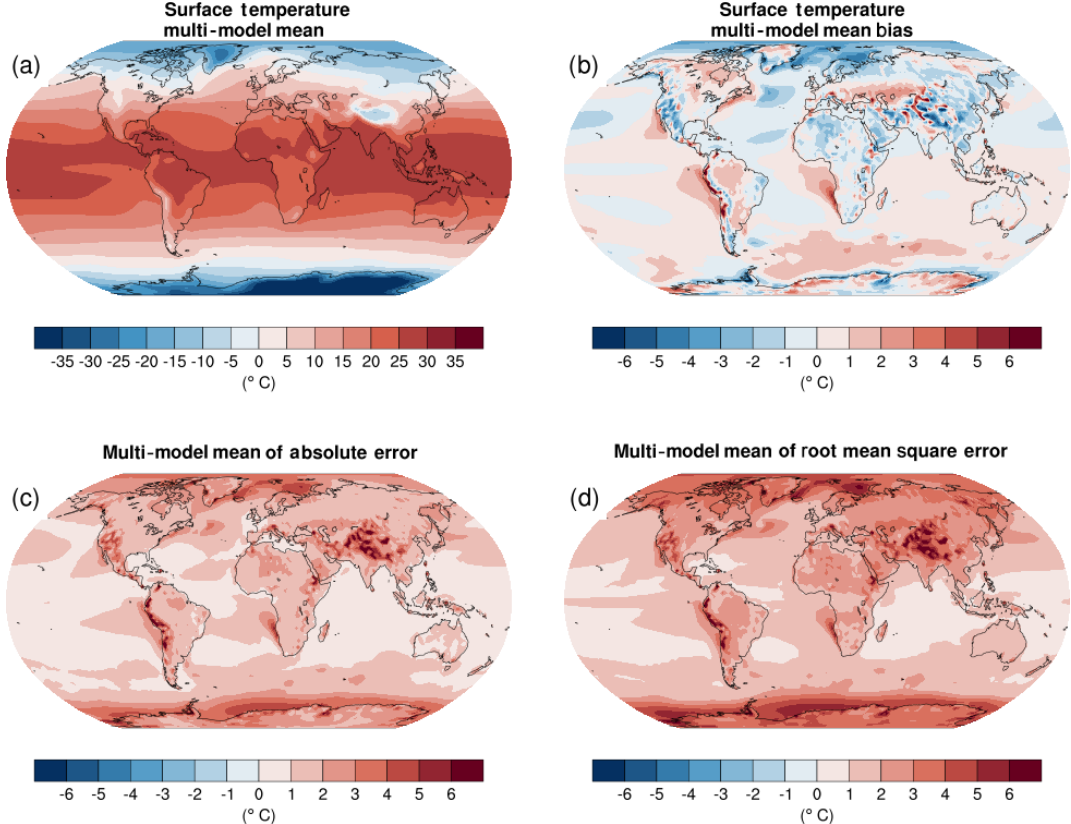
Figure 5. Annual-mean surface (2m) air temperature ( ◦ C) for the period 1980–2005. (a) Multi-model (ensemble) mean constructed with one realization of all available models used in the CMIP5 historical experiment. (b) Multi-model mean bias as the difference between the CMIP5 multi-model mean and the climatology from ECMWF reanalysis of the global atmosphere and surface conditions (ERA)-Interim (Dee et al., 2011). (c) Mean absolute model error with respect to the climatology from ERA-Interim. (d) Mean root-mean-square error of the seasonal cycle with respect to the ERA-Interim. Updated from Fig. 9.2 of IPCC WG I AR5 chap. 9 (Flato et al., 2013) and produced with recipe_flato13ipcc.yml ; see details in Sect.